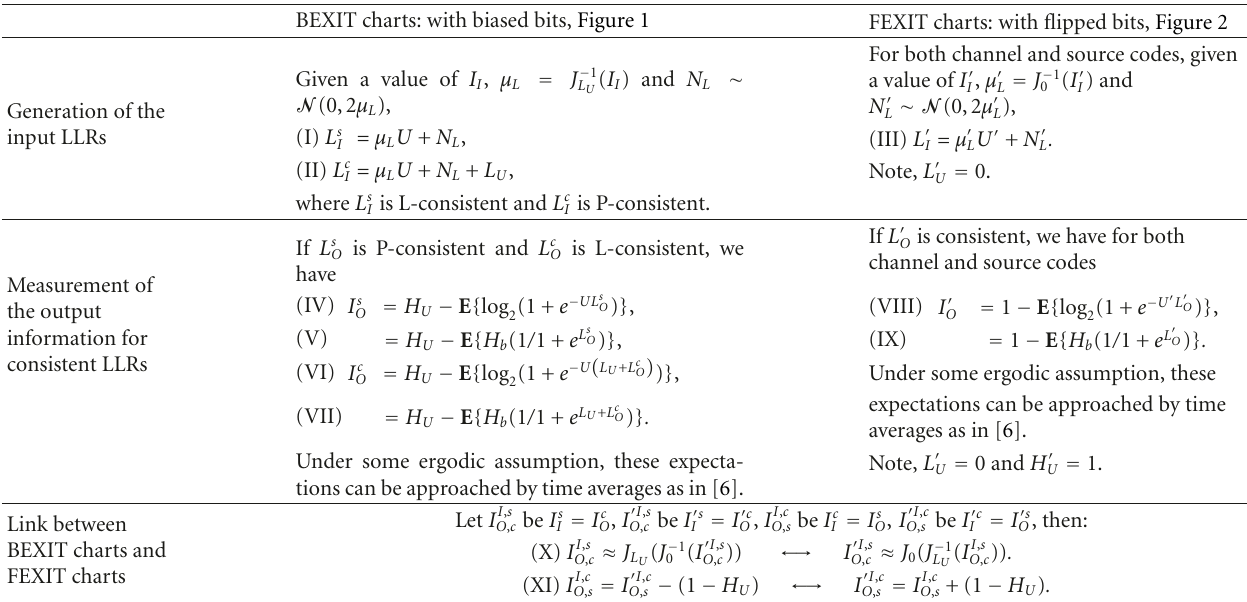
Table 1: Summary of the two Monte-Carlo methods. BEXIT charts: with biased bits, Figure 1 FEXIT charts: with flipped bits, Figure